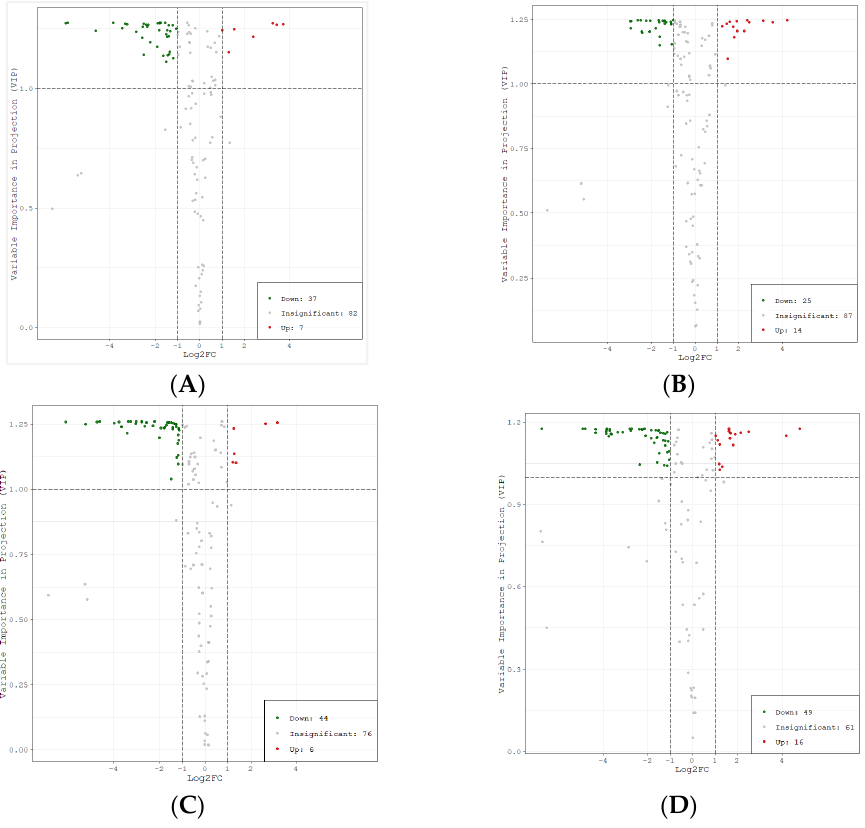
Figure 5. Volcano plots of different metabolites among litchi cultivars. Note: ( A ) BTY vs. FZX ( B ) FC vs. FZX ( C ) YJQ vs. FZX ( D ) BYL vs. FZX. Each point in the figure represents a metabolite; the abscissa represents the logarithm value of the multiple of quantitative difference of a metabolite in two samples, and the ordinate represents the VIP value. Fold change ≥ 2 indicates that the difference is up-regulated, and fold change ≤ 0.5 indicates that the difference is down-regulated. The green dot represents the down-regulated differential metabolite; the red dot represents the up-regulated differential metabolite, and the gray dots represent detected but insignificant